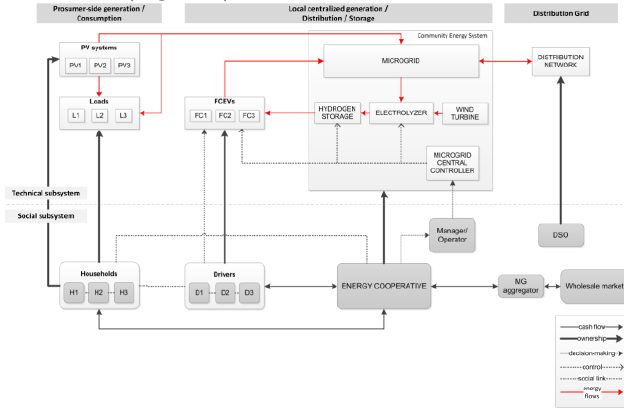
Figure 4. Diagram of the socio-technical system of a CaPP microgrid